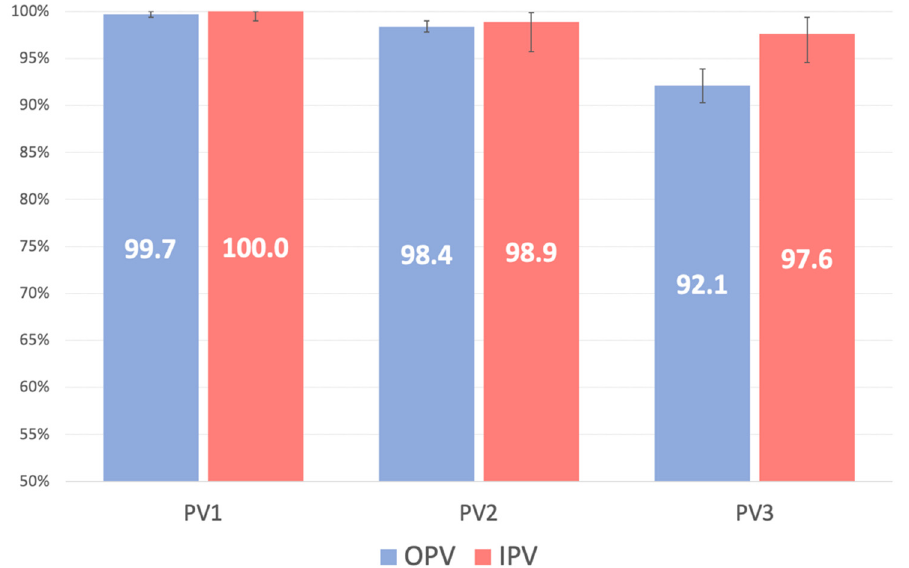
Figure 1. Prevalence (%) among the study participants of neutralizing antibodies, per poliovirus (PV) type. Table 1. Proportion of study participants without poliovirus (PV) neutralizing antibodies and the distribution of the titer (low–high) between groups with respect to vaccination and PV type.